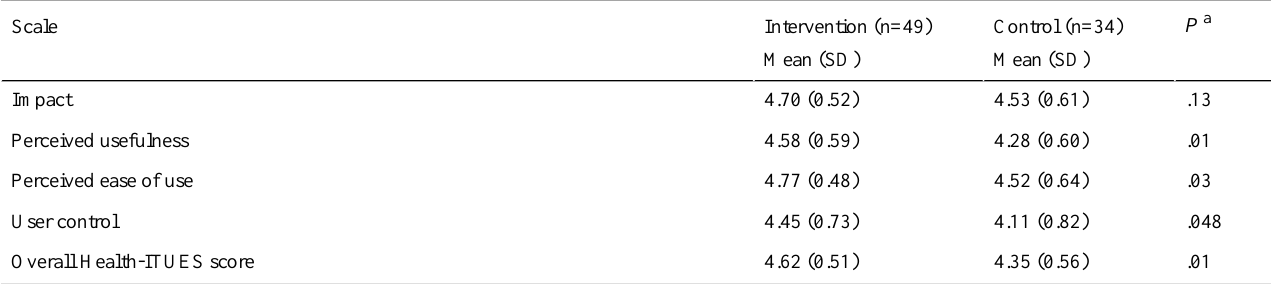
Table 4. Mean scale scores at baseline by intervention versus control groups for Health-ITUES subscales